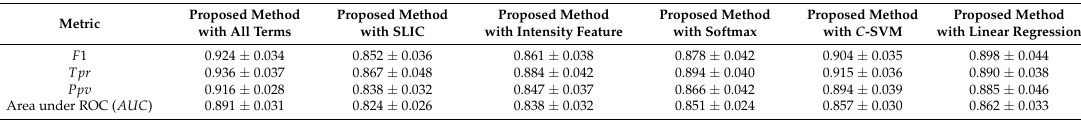
Figure 7. Receiver operating characteristics (ROC) curves of the proposed method with different modules. Table 1. Performances (average ± standard deviation) of variations of our method.